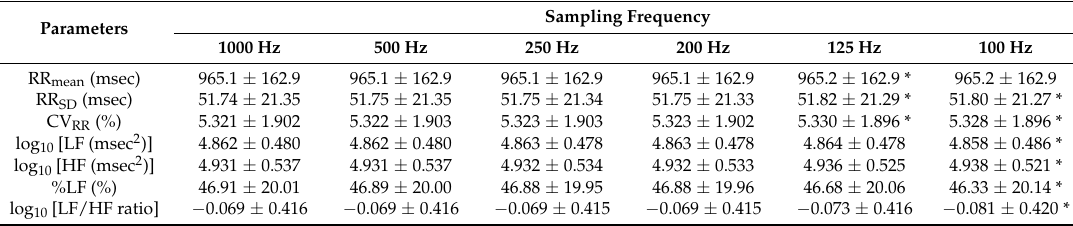
Table 3. Mean +/- SD values of HRV parameters measured at different sampling frequencies in 61 male students of reference